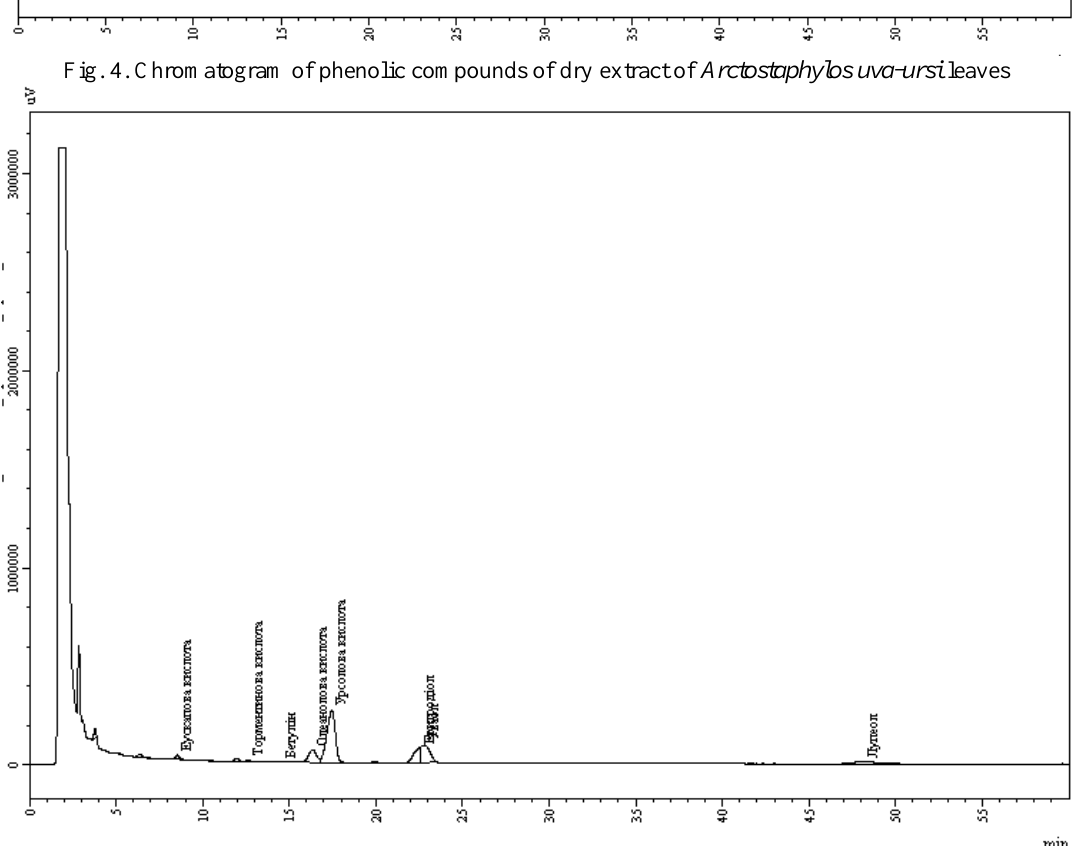
Fig. 4. Chromatogram of phenolic compounds of dry extract of Arctostaphylos uva-ursi leaves